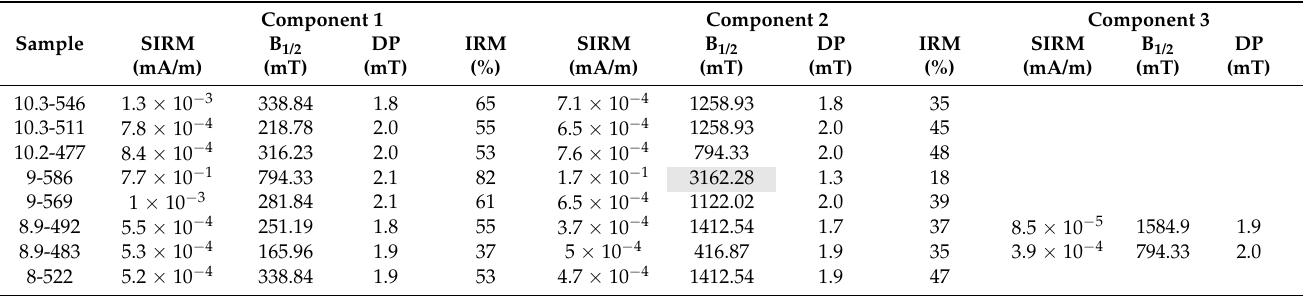
Figure 4. Analysis of the coercivity components of sample belongs to unit TD9 with the Kruiver approach. IRM acquisition curve and corresponding IRM components on a log-linear scale (LAP) where the circles represent measured data and the solid line the modelled one. Table 3. Input parameters (SIRM, B 1/2 and DP) of the components individuated for each unit in the Kruiver approach.